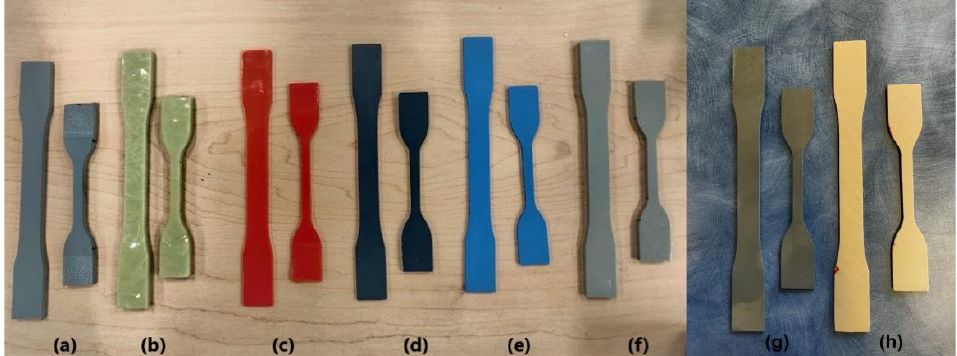
Figure 2. Coupon samples of Polyurea materials ( a ) S1, ( b ) S2, ( c ) S3, ( d ) S4, ( e ) S5, ( f ) S6, ( g ) S7, and ( h )